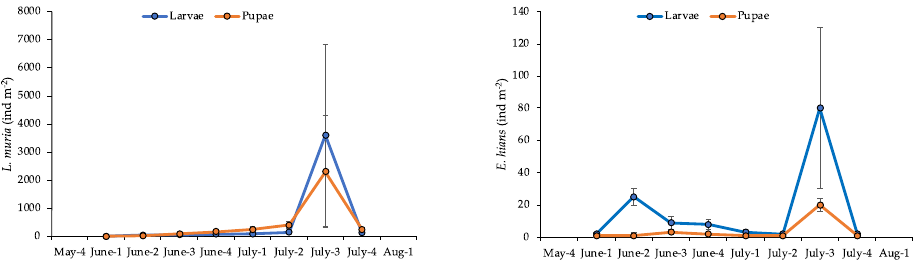
Figure 3. Temporal variation of Lamproscatella muria ( left ) and Ephydra hians ( right ) in Congotzio. (Dates are indicated in weeks of each month).